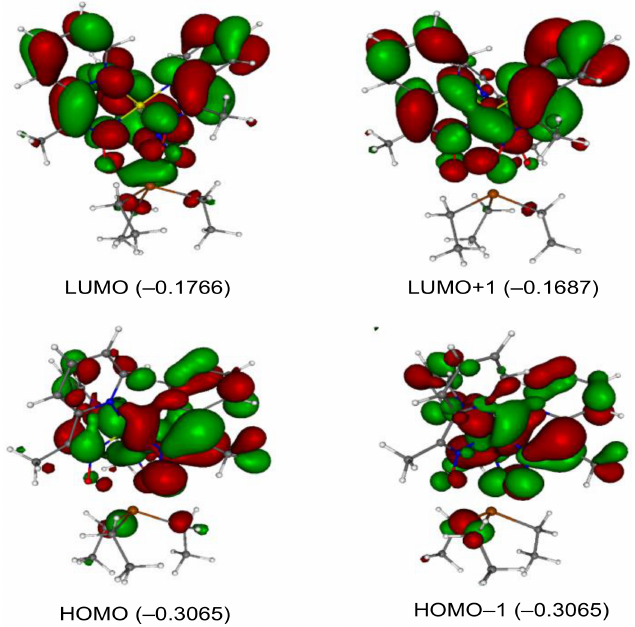
Figure 8. B3LYP/LanL2DZ HOMO–1, HOMO, LUMO, and LUMO+1 orbitals of the precursor 14 ; the corresponding relative orbital energies in a.u. are given in parenthesis. The isovalue is set to ±